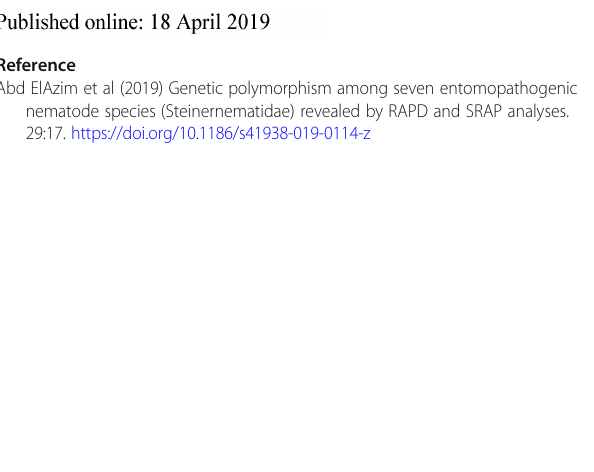
primers used to assess the genetic variability among the seven steinernematid